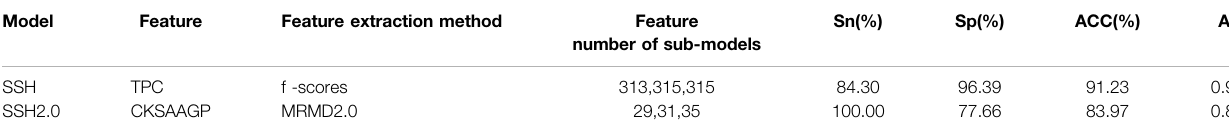
TABLE 5 | Comparison of the feature and performance between SSH2.0 and SSH.